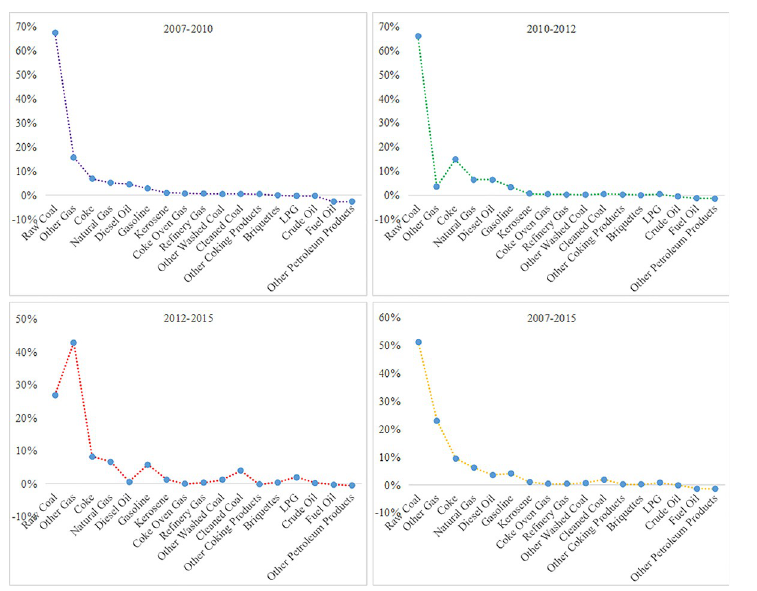
Fig 2. Contribution of various energy sources to CO 2 emissions growth from 2007 to